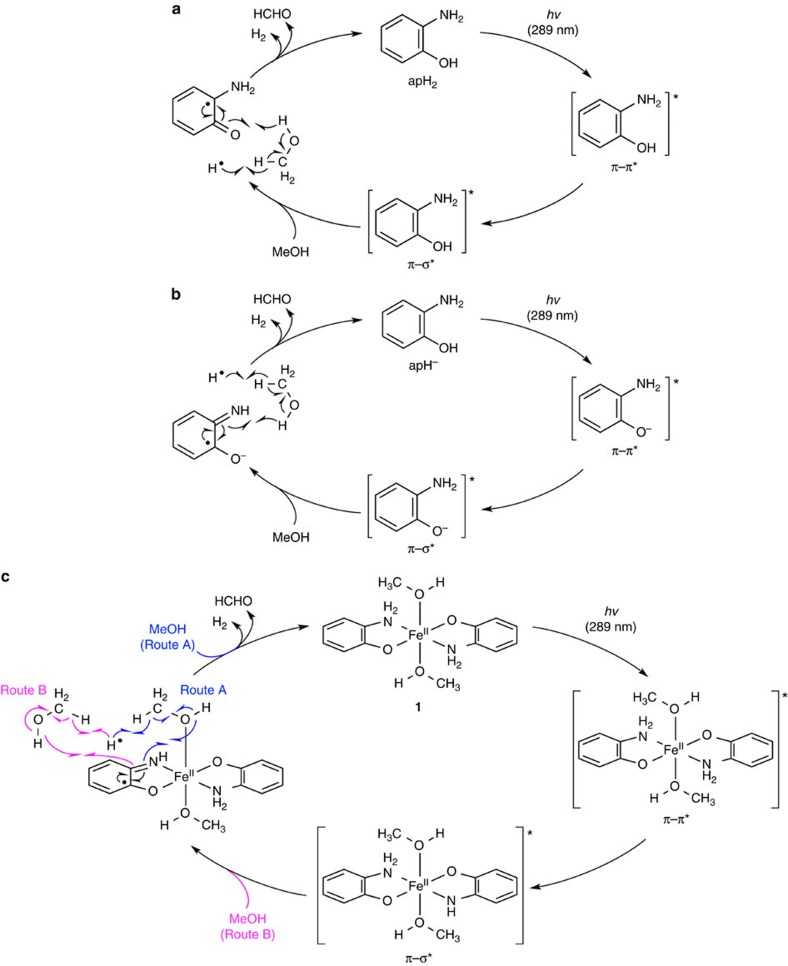
Plausible PHER mechanisms.Reaction cycles catalysed by (a) apH2, (b) apH− and (c) 1 upon irradiation at 289±10 nm.